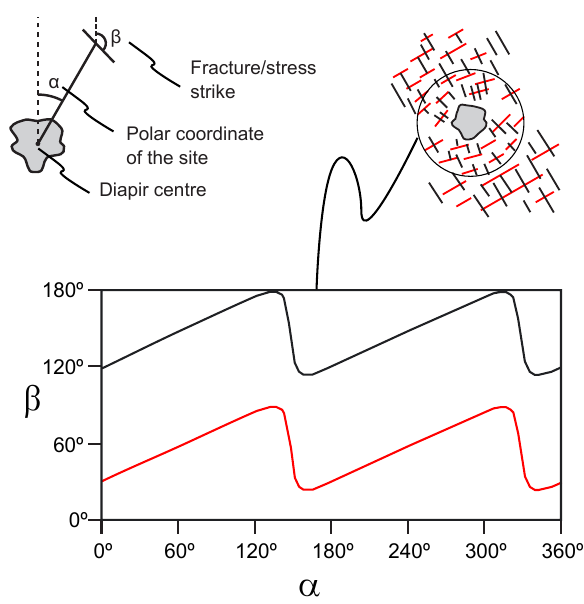
Fig. 10. Map view of the relationships between fracture/stress strike and polar coordinate in a diapir where the acting stress field results from the interaction between regional and doming-related compo- nents (See Quinta et al.,